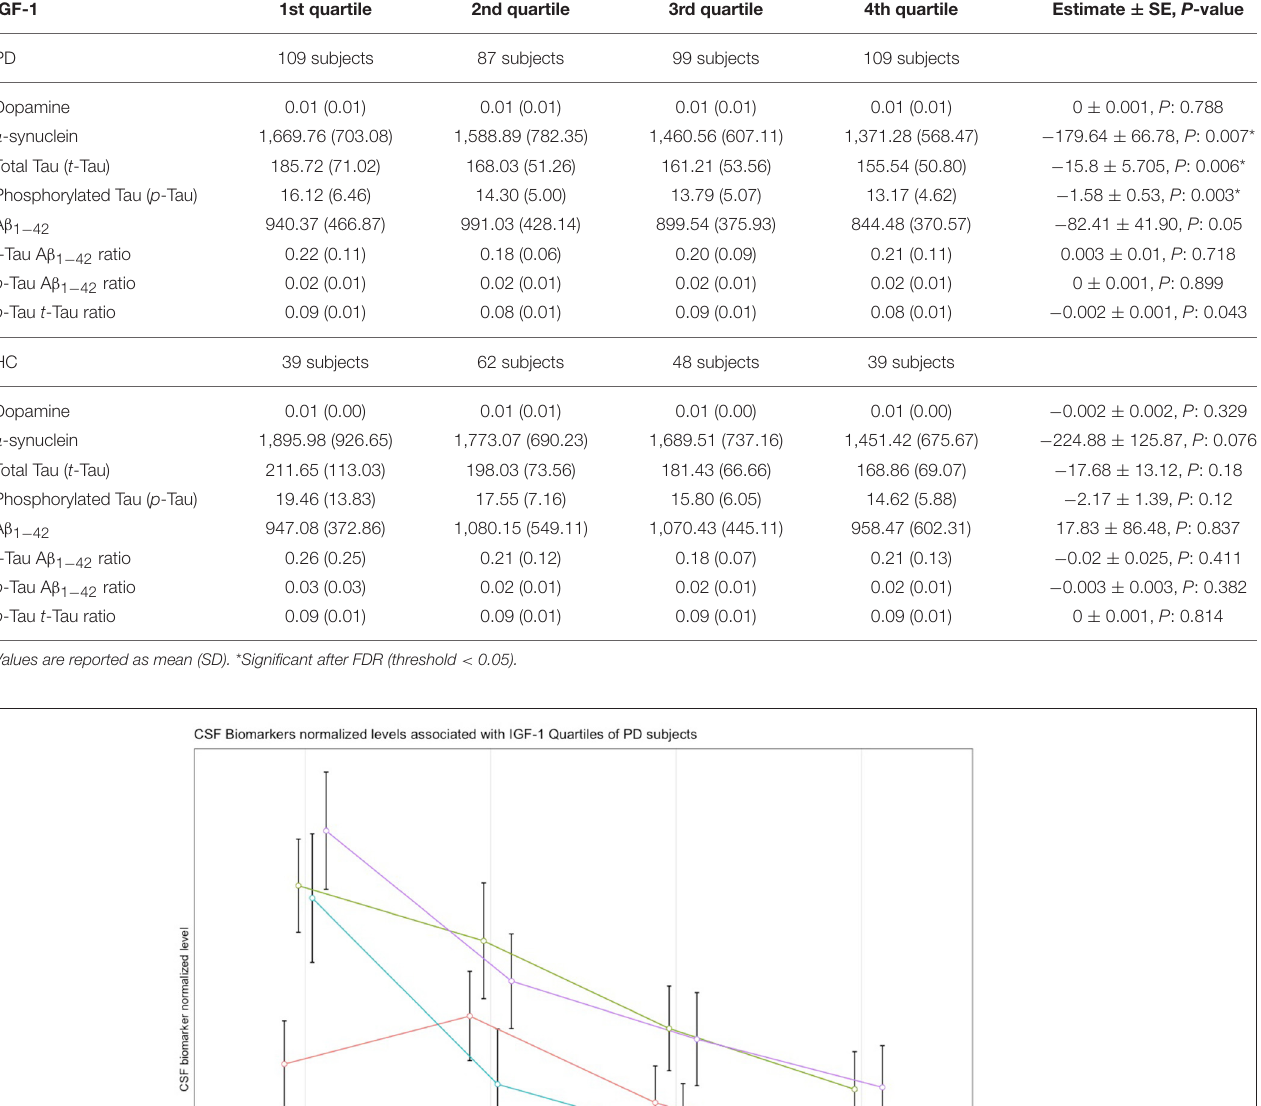
(43, 44). The cingulum bundle and CC have pivotal roles in cognitive function. The most anterior parts of these structures contribute to goal-directed behavior and attention modulation through the network of prefrontal projections, while the most posterior parts are involved in regulating memory with their